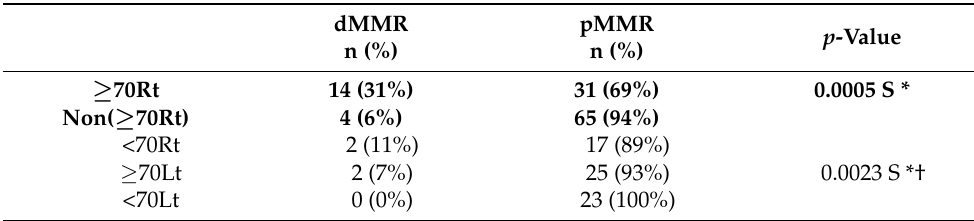
Table 1. Status of mismatch repair protein (MMR) of postmenopausal colon cancer according to patients’ age and tumor